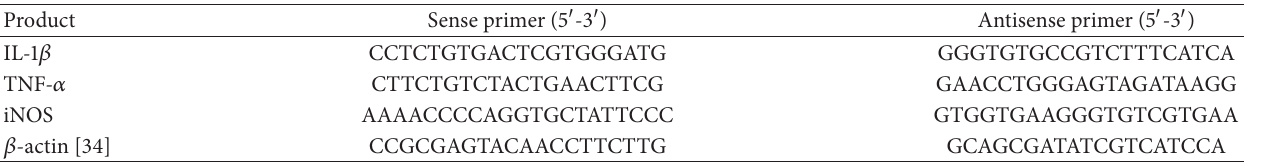
Table 2: Primer sequences.